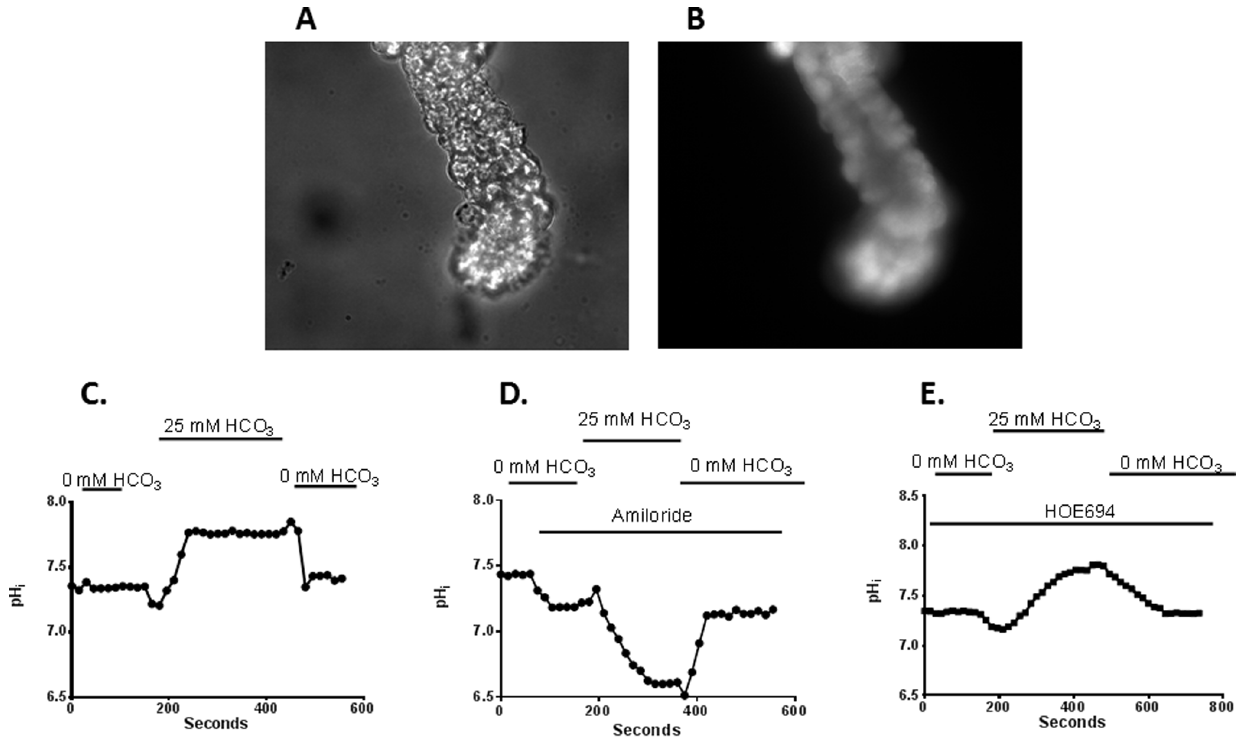
Figure 1. Effect of extracellular HCO 3 in the presence and absence of HOE694 on intracellular pH change in crypt glands from proximal colon. Images of a crypt gland before [ A ] and after BCECF loading [ B ]. The BCECF loaded crypts were excited at 490 nm and 440 nm and the emission signal was monitored at 535 nm to derive intracellular pH (pHi). [ C ] Under basal condition, bath HCO 3 increased pHi, while the increased pHi was completely reversed by HCO 3 removal. [ D ] In the presence of amiloride, bath HCO 3 reduced the pHi, while the reduced pHi was partially reversed by HCO 3 removal. [ E ] In the presence of HOE694, bath HCO 3 increased pHi, while the increased pHi was completely reversed by HCO 3 removal. Typical tracing presented is representative of observations in 4 different crypts from 5 different